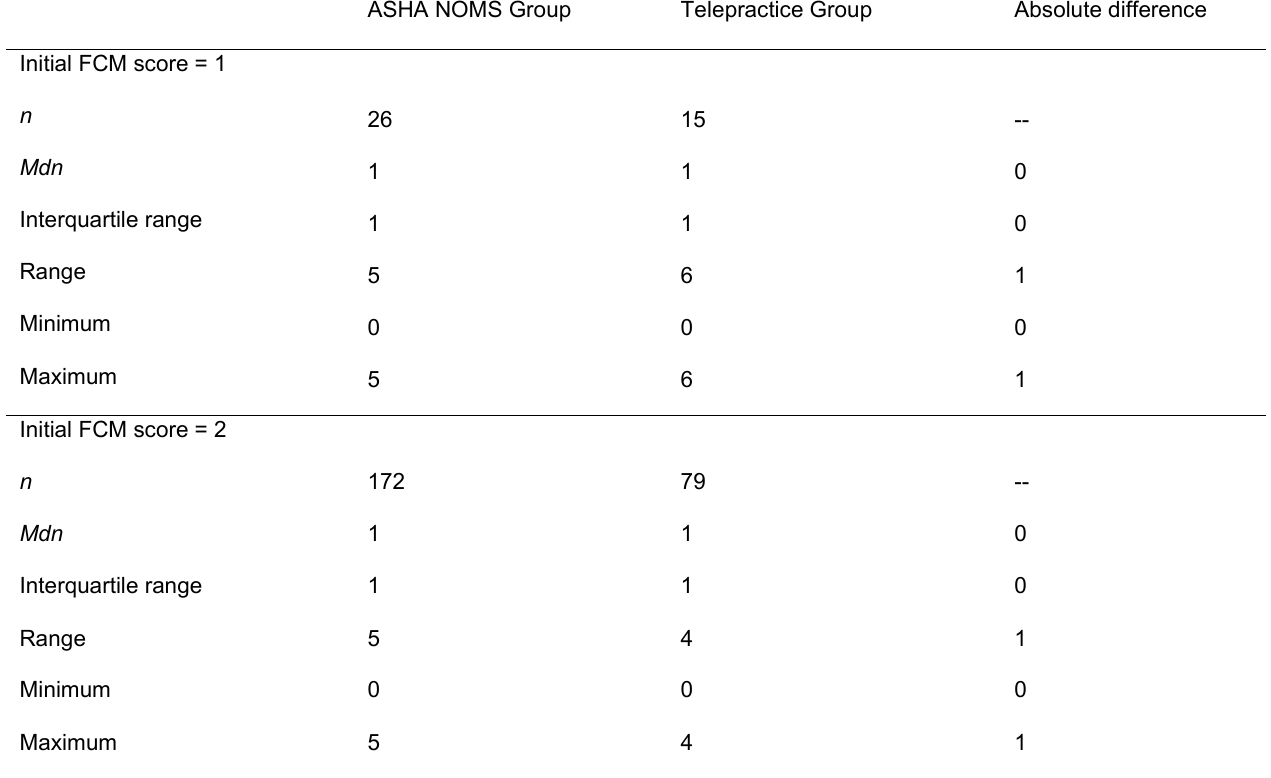
Distributional Data for Change Scores Associated with Each Severity Subgroup by Intervention Modality ASHA NOMS Group Telepractice Group Absolute difference Initial FCM score =